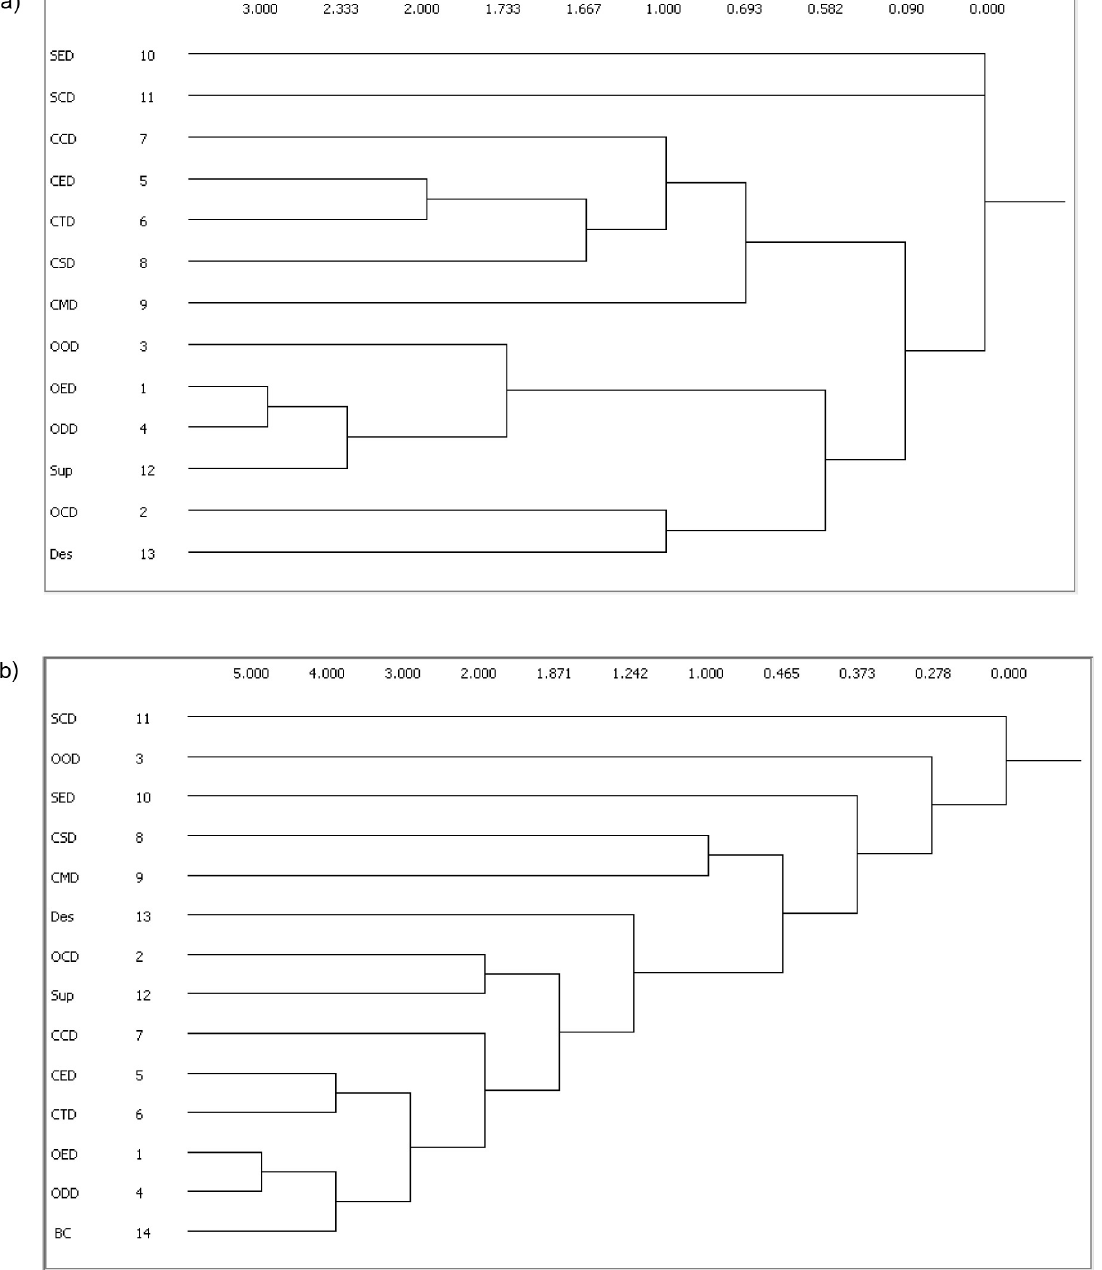
PLOS ONE | https://doi.org/10.1371/journal.pone.0275833 October 11,